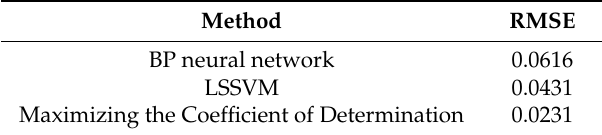
Figure 10. Comparison between the soft sensor based on maximizing the coefficient of determination and laboratory measurements.